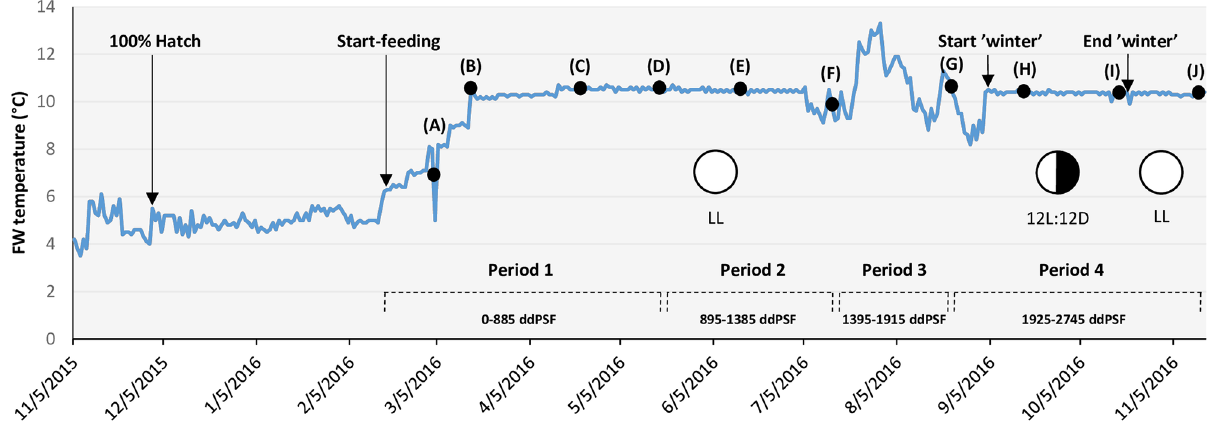
Fig 1. Overview of rearing conditions and sampling points during the trial. Periods 1–4 cover 0–2745 degree-days post start-feeding (ddPSF). Fish growth expressed as the Thermal Growth Coefficient (TGC) was calculated from bulk weight increase during each period. Black dots indicate intermediate sampling points where 25 fish per tank were weighed and measured. Arrows indicate other events or operations. FW = freshwater; LL = constant light; 12L:12D = light regime used during ‘winter’ stimulation. Sampling points: (A) 95 ddPSF; (B) 218 ddPSF; (C) 580 ddPSF; (D) 875 ddPSF; (E) 1168 ddPSF; (F) 1455 ddPSF; (G) 1888 ddPSF; (H) 2090 ddPSF; (I) 2454 ddPSF; (J) 2745 ddPSF.